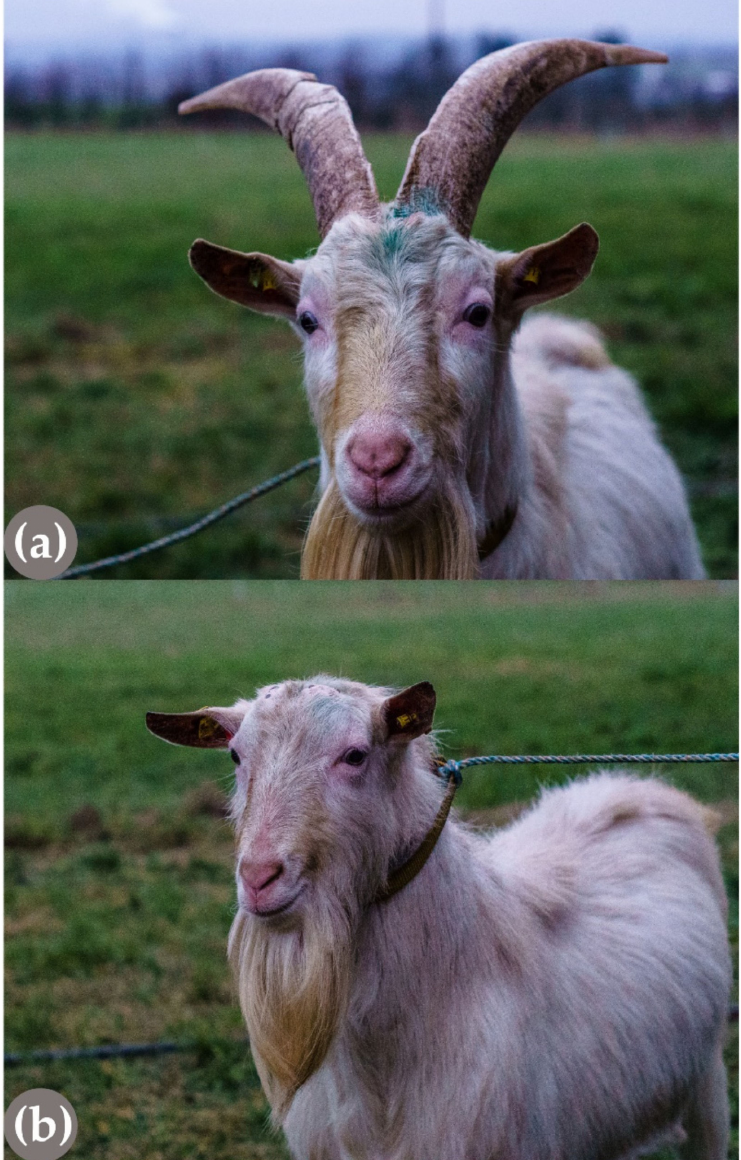
Figure 4. A horned ( a ) and heterozygous polled ( b ) Saanen buck, sired by the same heterozygous polled father. Both rams were about 1.5 years old when the pictures were taken (C.